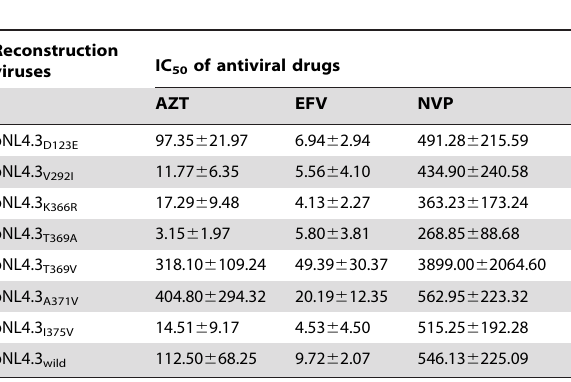
Table 3. IC 50 (nM) of constructed viruses for three antiviral